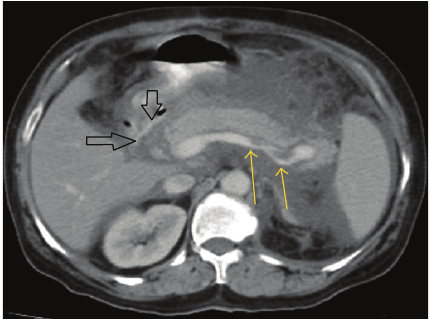
Figure 2: The smaller yellow arrows indicate the filing defect (thrombosis) in the splenic vein and large black arrows point to necrotic areas of head of